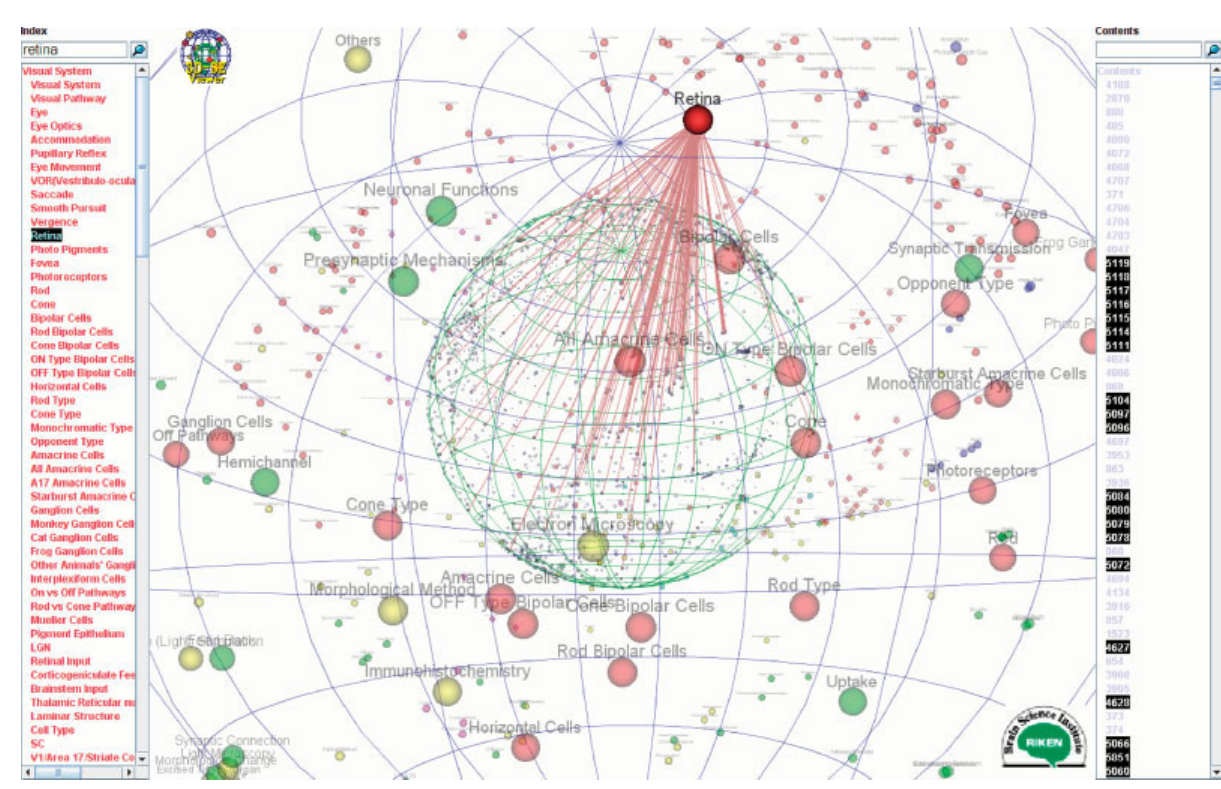
Figure 3. Visualization of Visiome Platform index keywords and contents . The searched term retina found in the index keywords list is selected, showing simultaneously all the links to related